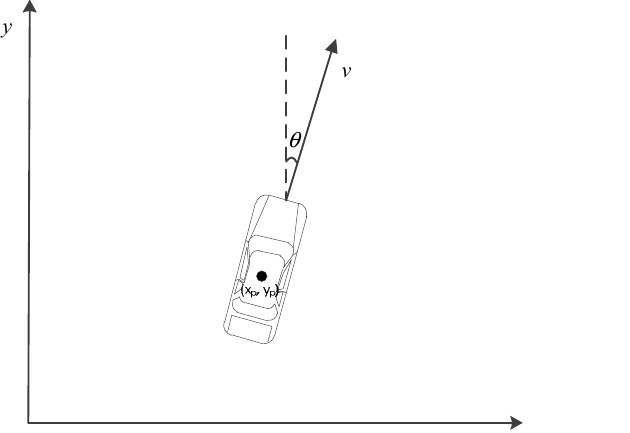
Figure 2. Moving state of a vehicle.